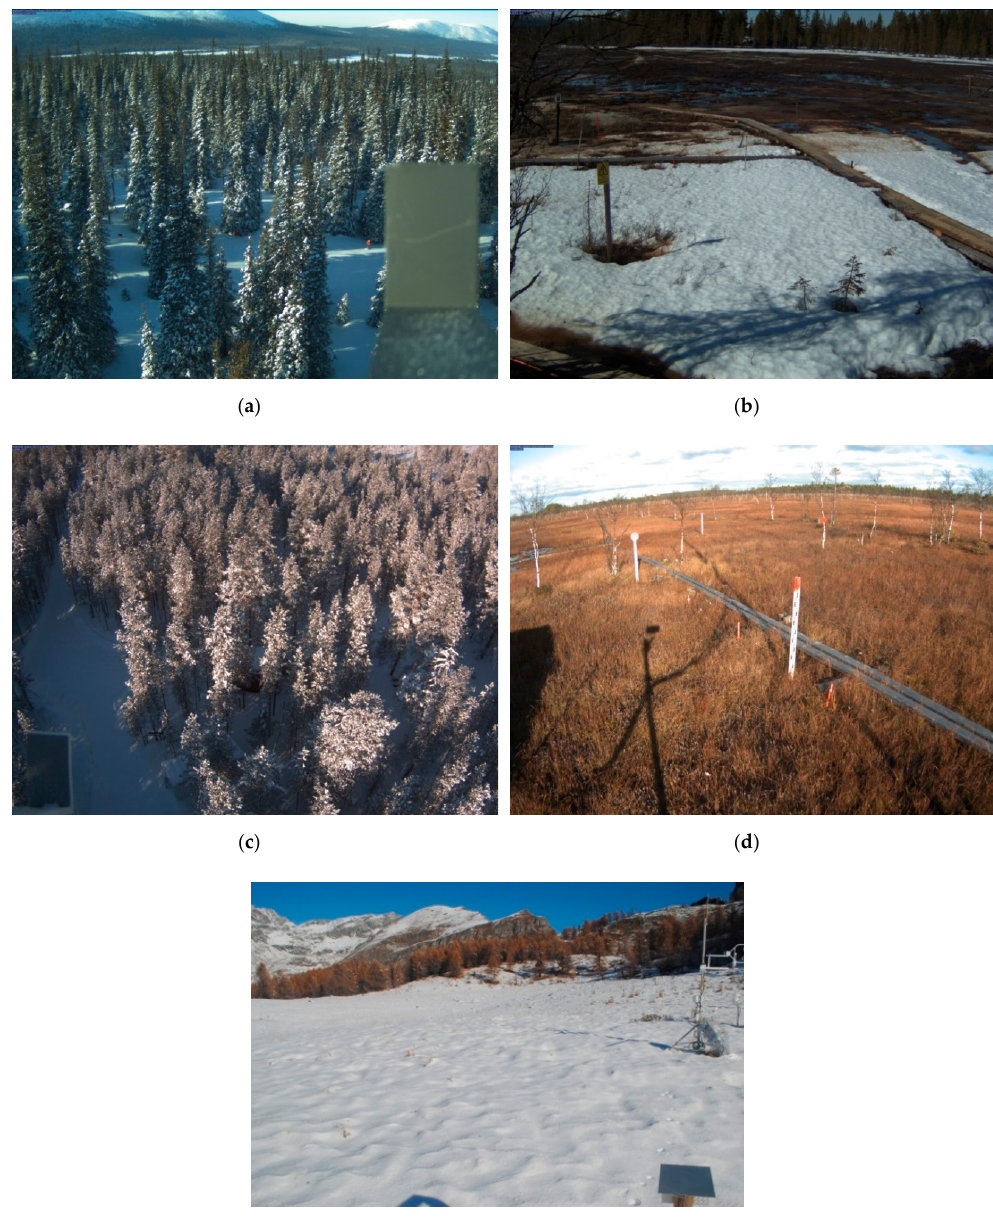
Figure 7. Webcam field of views: ( a ) Kenttärova canopy camera, ( b ) Lompolojankka peatland camera, ( c ) Sodankylä canopy camera, ( d ) Sodankylä peatland camera, ( e ) Torgnon camera.